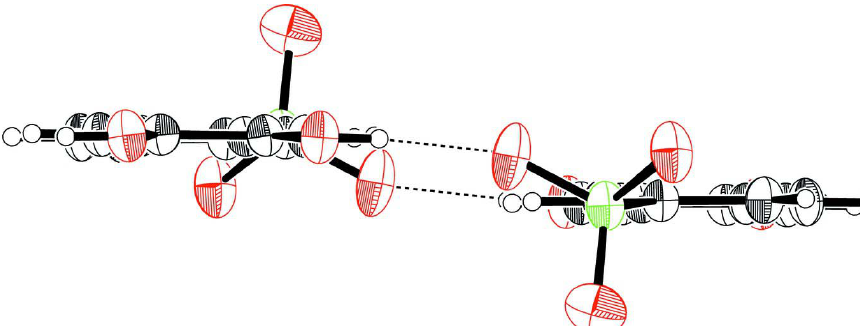
Figure 3 Hydrogen-bonded dimer unit A (side